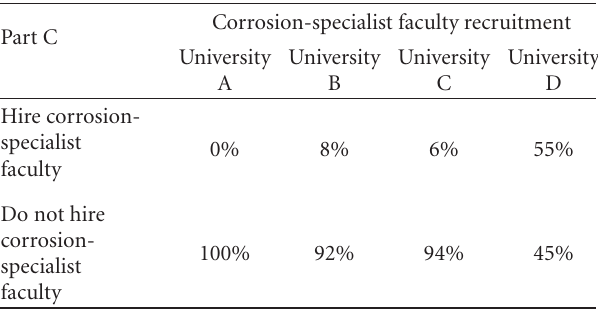
Table 6: Resources: faculty